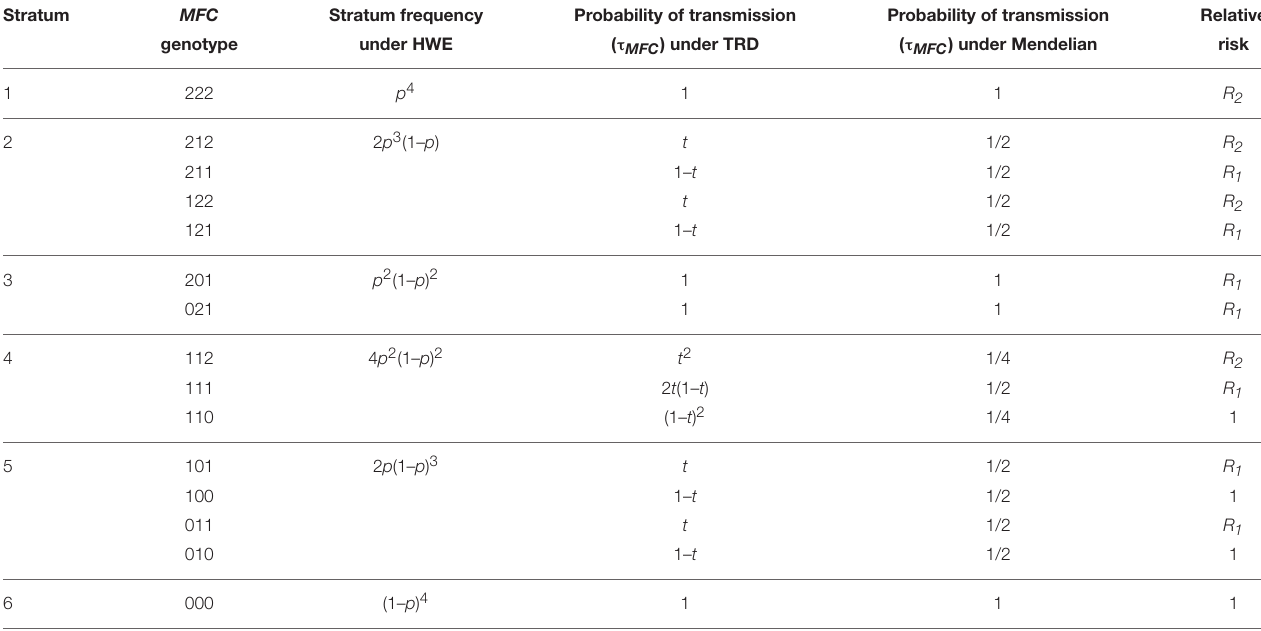
TABLE 1 | Relative risk, stratum frequency, and probability of transmission (TRD or Mendelian) for Case-parent trios study design. Stratum MFC Stratum frequency Probability of transmission Probability of transmission Relative genotype under HWE ( τ MFC ) under TRD